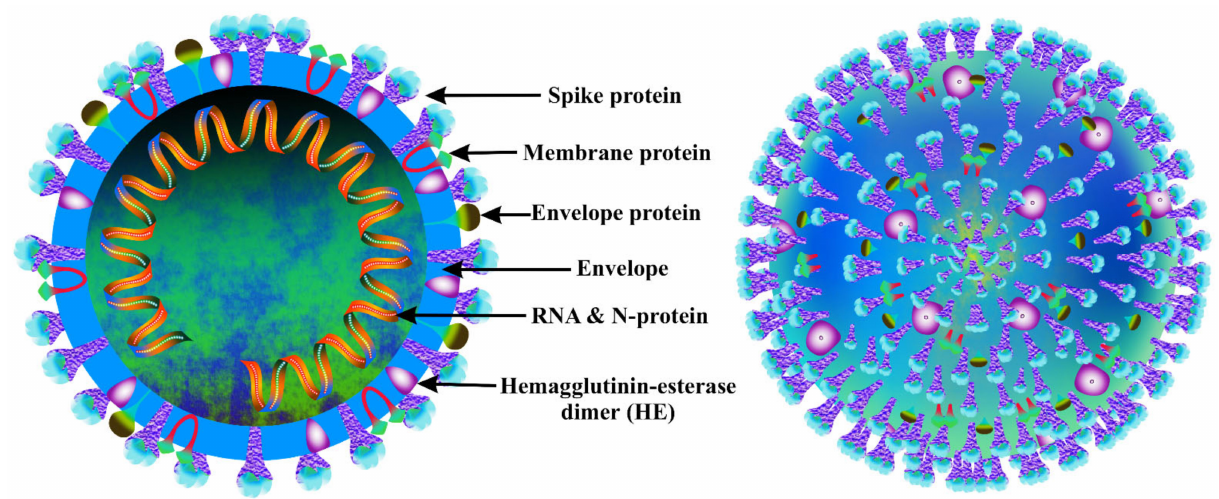
Figure 1. Cross-section ( left ) and outer structure ( right ) of the